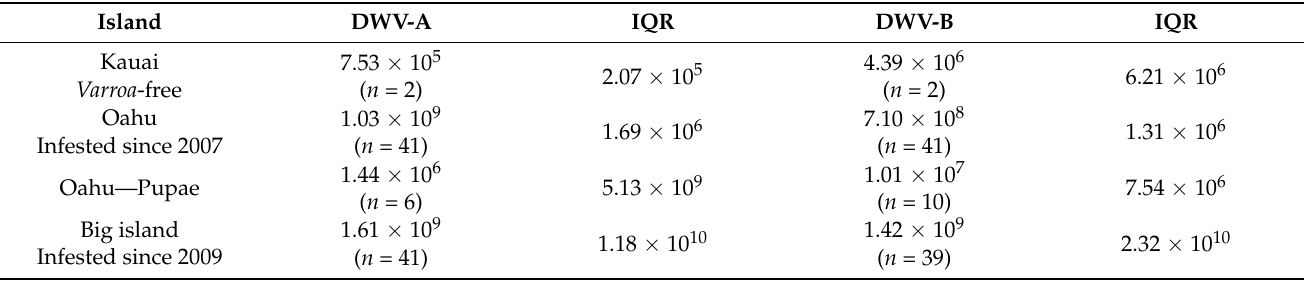
Table 1. Island median DWV genome equivalent and interquartile range (standard range for Kauai) and the year Varroa was first detected on each island.